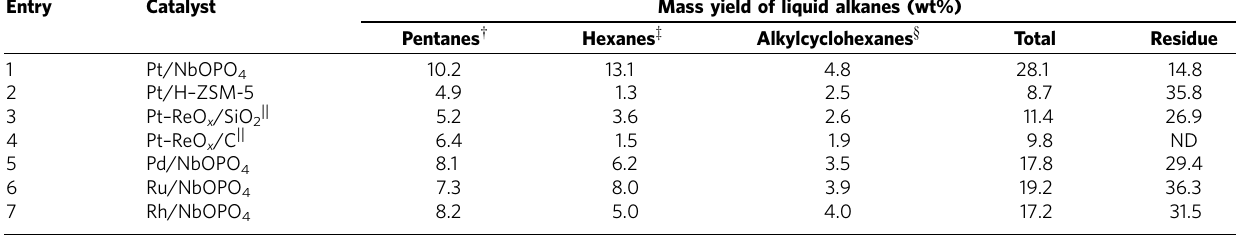
Table 2 | The results of direct hydrodeoxygenation of birch wood over different catalysts.*